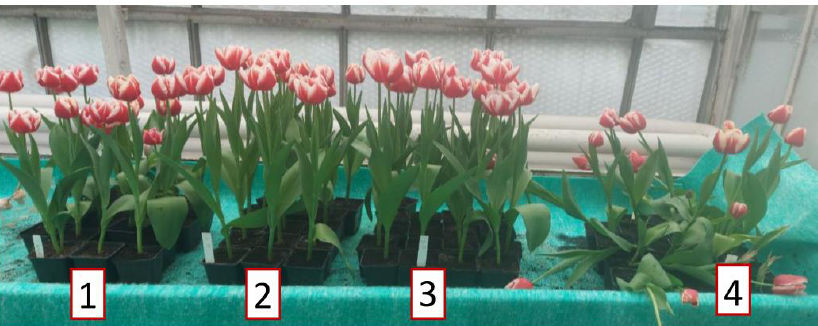
Figure 1. The effect of treatment with BTHWA on the stimulation of tulip height and vigor. (1) UTC (not inoculated); (2) plants treated with BTHWA 20 mg/L; (3) plants treated with BTHWA 40 mg/L; (4) UTC (inoculated).